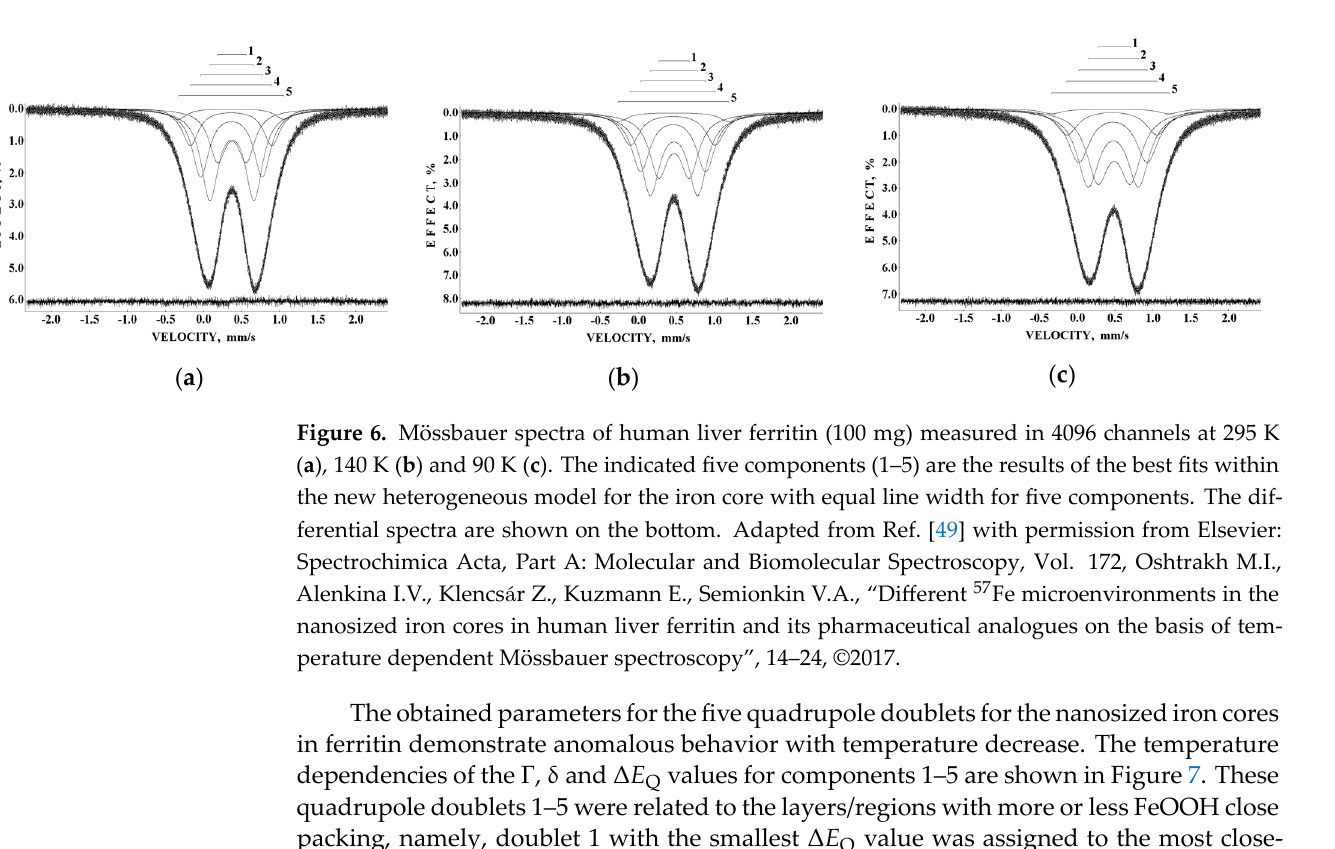
Figure 5. Anomalous temperature dependencies of the line width obtained within one doublet fit (two dashed lines indicate two different slopes, ■ and ▲ are the experimental data) ( a ) and normalized total spectral areas (dashed line is polynomial approximation for the experimental values ▲ ) ( b ); and estimation of Θ M for ferritin from temperature dependence of isomer shifts ( △ ) obtained within one doublet fits (solid line is the fit using Equation (1)) ( c ). Adapted from Ref. [45].